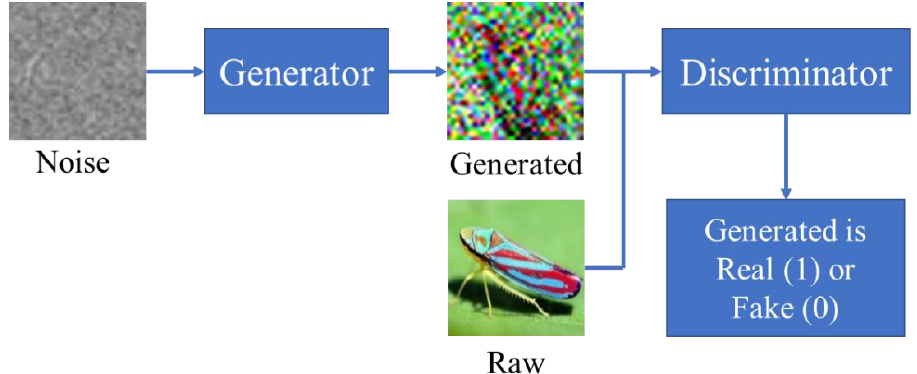
Figure 6. The workflow of generative adversarial network (GAN).